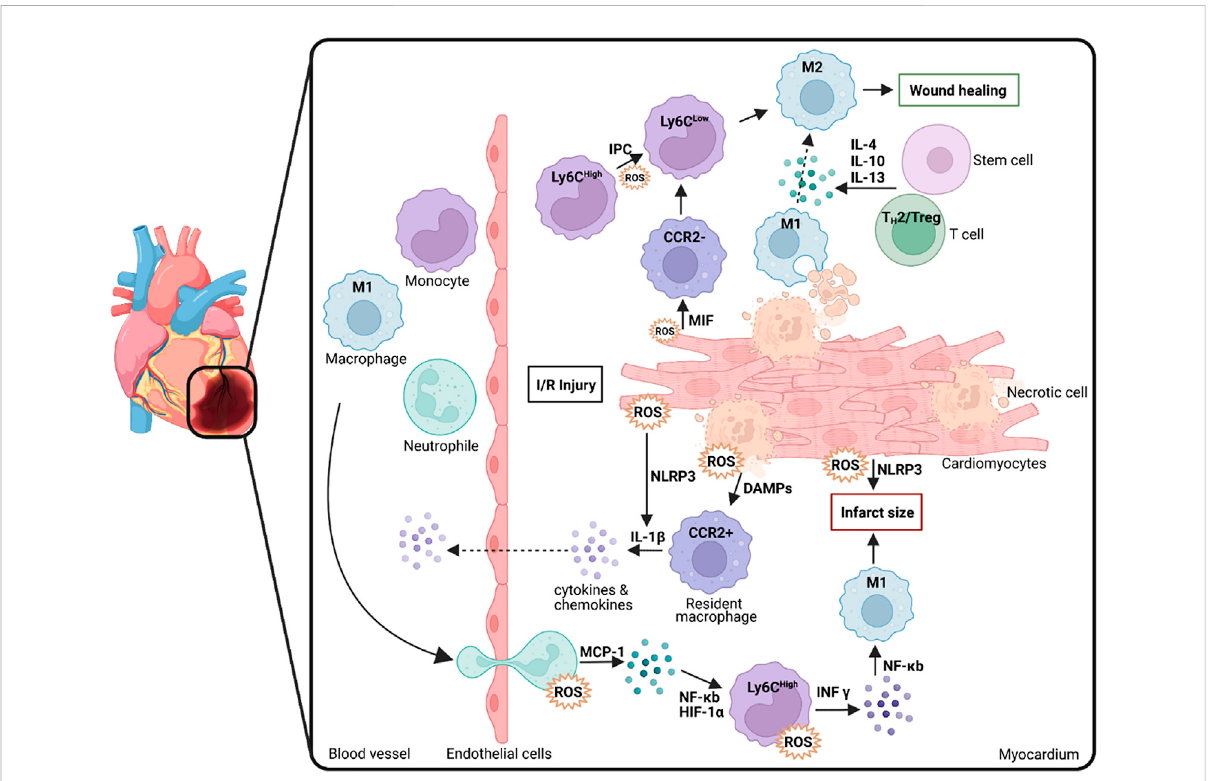
FIGURE 1 Macrophagepolarization,in fi ltrationandROSgenerationfollowingmyocardialdamage(e.g.,throughI/Rinjury).Macrophagesarecrucialinthe process underlying tissue in fl ammation as well as wound healing and in fl ammatory resolution thereby determining the degree of infarct size. M1: macrophages with M1 polarization; Ly6C: Lymphocyte antigen 6 complex locus C; M2: macrophages with M2 polarization; IL: Interleukin; CCR2: C-Cchemokinereceptortype2;ROS:Reactiveoxygenspecies;IR:Ischemia/reperfusion;MIF:Macrophagemigrationinhibitoryfactor;NLRP3: Family pyrin domain containing 3; DAMP: Damage-associated molecular pattern; MCP: Monocyte Chemoattractant Protein-1 (CCL-2); NF- κ B: Nuclear Factor KappaB; HIF-1 α : Hypoxia inducible factor 1 alpha; INF- γ : Interferon gamma; IPC: Ischemic preconditioning, Treg: RegulatoryT cells; T H 1/2: T Helper cells 1/2. Scheme was summarized from data in (Daiber et al., 2021). Created with